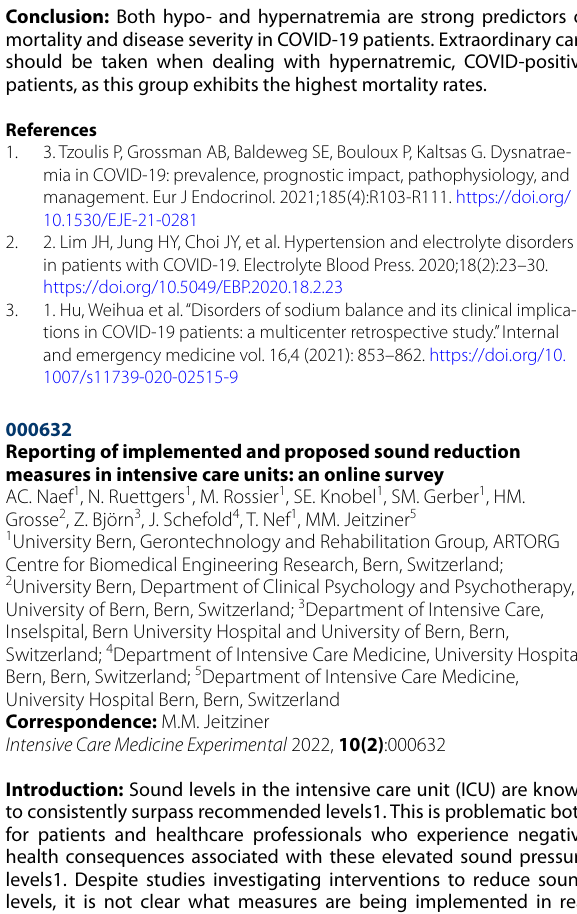
Table 1: Implemented and proposed sound reduction measures. Measures were grouped into four main categories. The number of responses can be higher than the number of participants as they could indicate multiple implemented or proposed